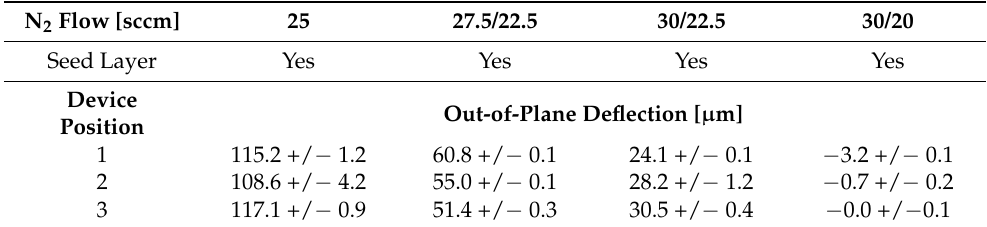
through the five layers. Each die was pull from the north (N), northeast (NE), east (E), southeast (SE), south (S), southwest (SW), west (W), and northwest (NW) locations of the wafer shown in Figure 3b. Table 3. Cantilever tip deflection for a die near the center of a 500 nm Al 0.68 Sc 0.32 N film with AlN and Sc gradient (Al 1 → 0.68 Sc 0 → 0.32 N) seed layers.